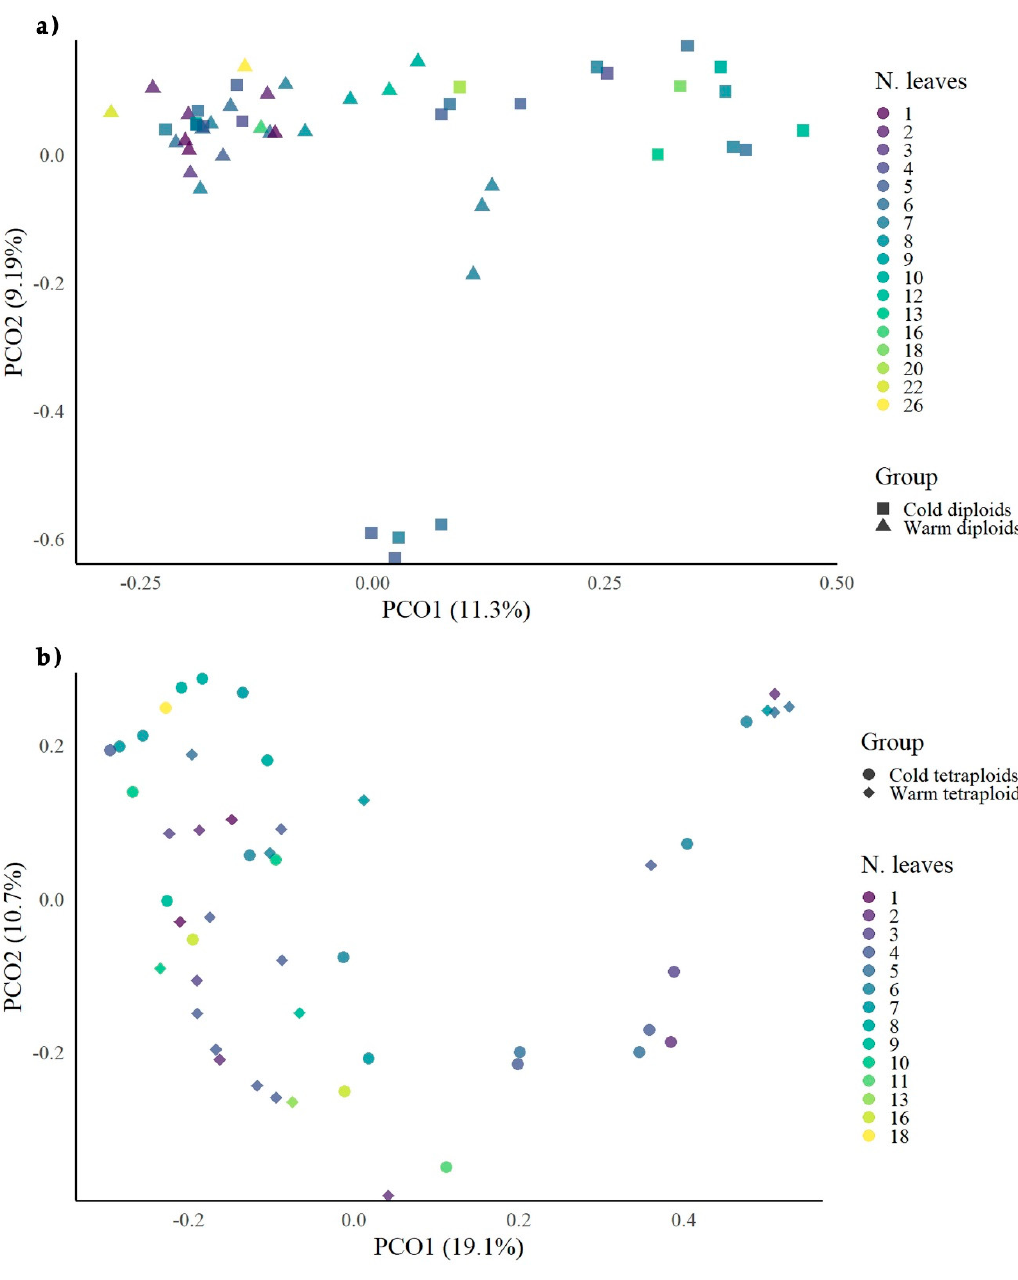
Figure 4. PCoAs of DNA methylation patterns (MS-AFLPs) against the number of leaves on treatment level of Ranunculus kuepferi diploid and tetraploid individuals: ( a ) diploid plants; ( b ) tetraploid plants. Further comparisons of the two datasets via linear models (LMs) and generalized linear models (GLMs) unveiled that nonmethylated epiloci (predictor) have a significant and a slightly significant negative correlation with leaf length and number of leaves (responses), respectively (Table